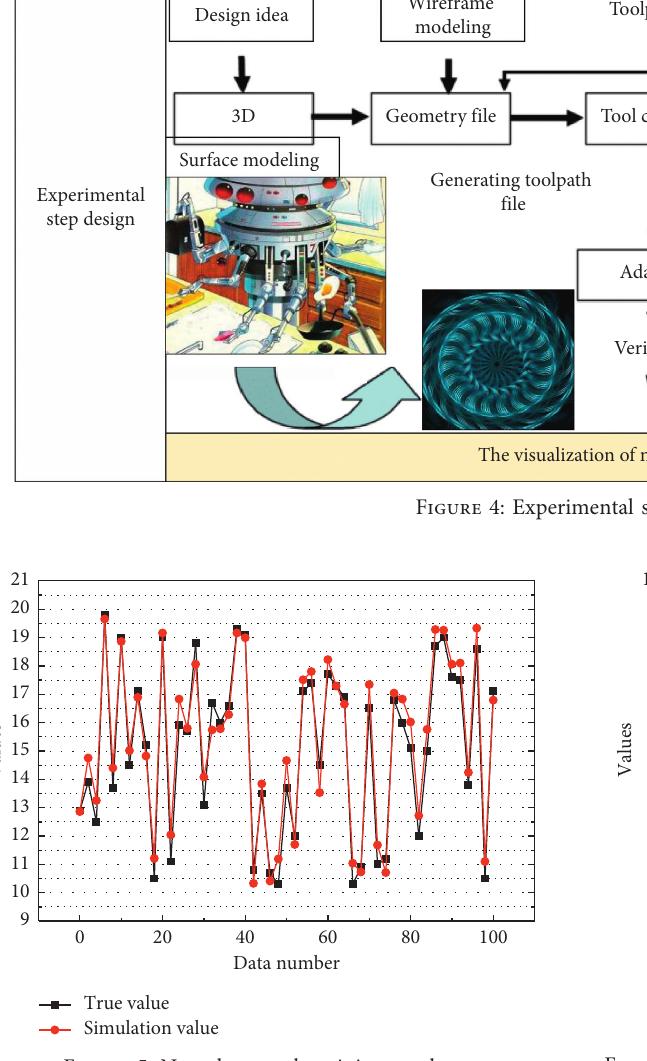
Figure 5: Neural network training results. Figure 6: Model training results under the combination of 1-1- corresponding to table separation speed-table separation distance-squeegee pressure-squeegee speed-cleaning speed- automatic cleaning count, respectively.